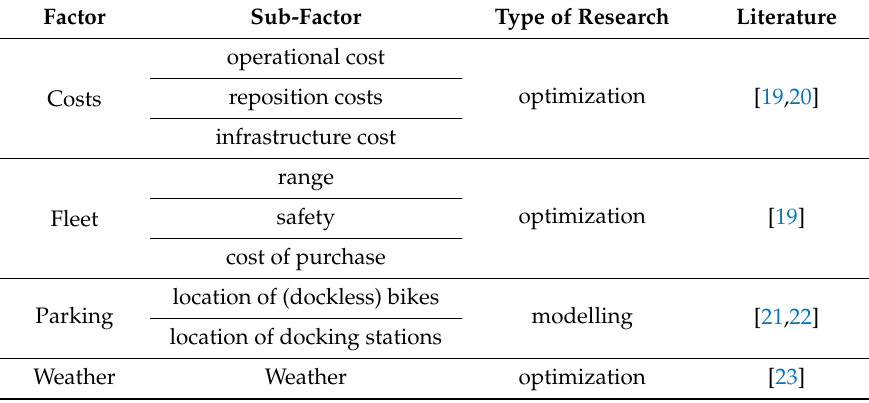
Table 1. Factors that are taken into account when modeling and optimizing electric bike-sharing systems—a literature